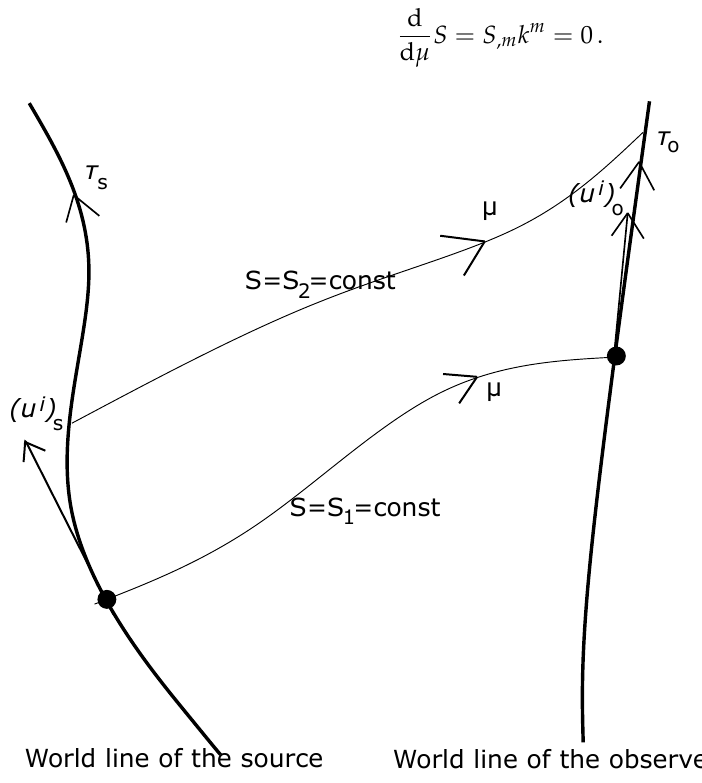
Figure 1. Isotropic geodesics intersecting the world lines of the source and the observer. Consider a set of such surfaces S = S 1 , S = S 2 . . ., for which e i ω S ( x ) has a maximum. This corresponds to the maximum value of the electromagnetic field. Part of the world line of the source/observer between two nearest surfaces (for example, S = S 1 and S = S 2